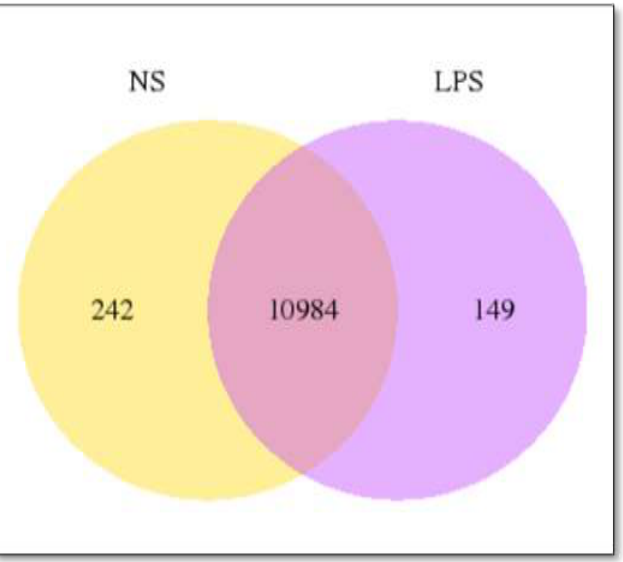
Figure 1. Summary of RNA-seq data. Venn diagram showing the number of expressed genes (nor- malized expression values > 1) in C. rotundicauda non-stimulated (NS) and LPS-stimulated (LPS) samples.